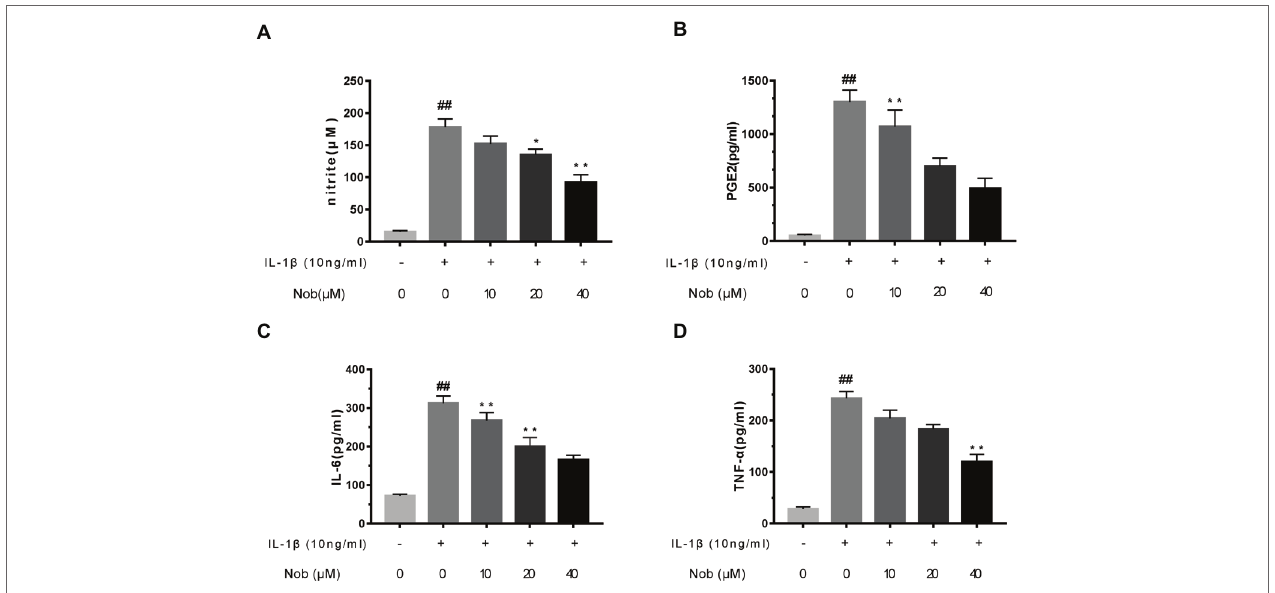
FIGURE 2 | Effect of nobiletin on IL-1 β -induced NO, PGE2, IL-6, and TNF- α production in mice OA chondrocytes. Chondrocytes were pretreated for 24 h with various concentrations of nobiletin (10, 20, or 40 μM) and then incubated for 24 h with or without IL-1 β (10 ng/ml). Nitrite levels in the culture medium were assessed by Griess reaction (A) . Concentrations of PGE2, IL-6, and TNF- α were determined using ELISAs (B–D) . Values represent mean ± SD of three independent experiments. * p < 0.05, compared with control group. * p < 0.05 and ** p < 0.01, compared with IL-1 β group. ## p < 0.01, compared to the control